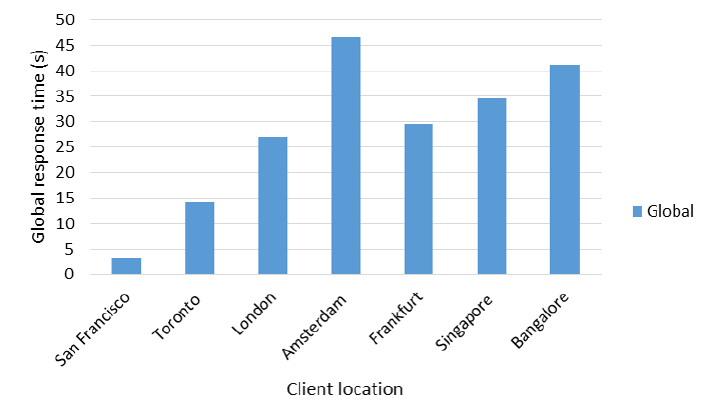
Figure 10. Global response times according to client